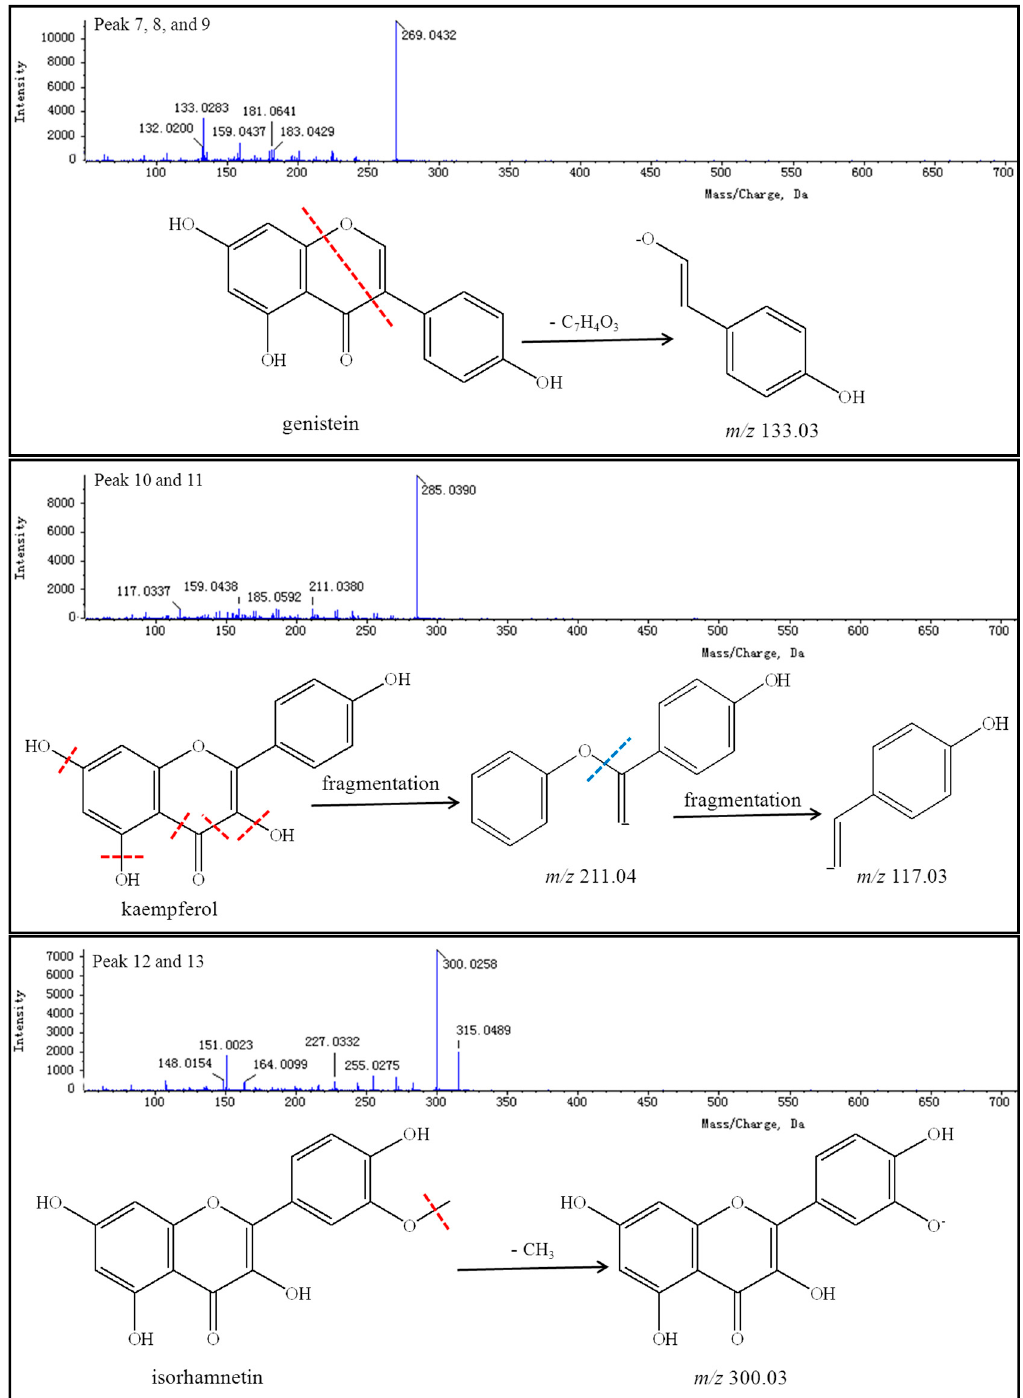
Figure 13. Structure, MS/MS spectra and fragmentation scheme (negative ion mode) of 13 ingredients (the red lines and blue lines are cracking location and ion fragments figure, respectively).